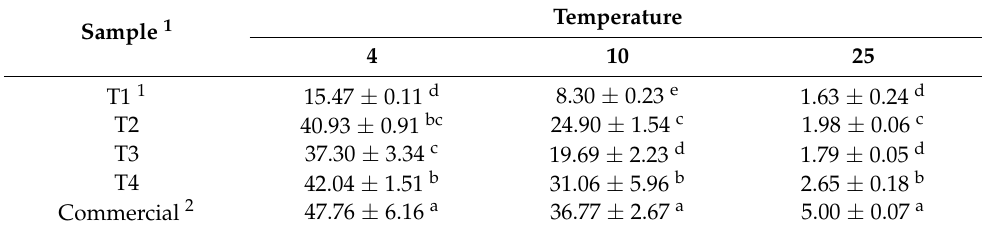
Table 2. Delta values in Greek yogurt at 4, 10, and 25 ◦